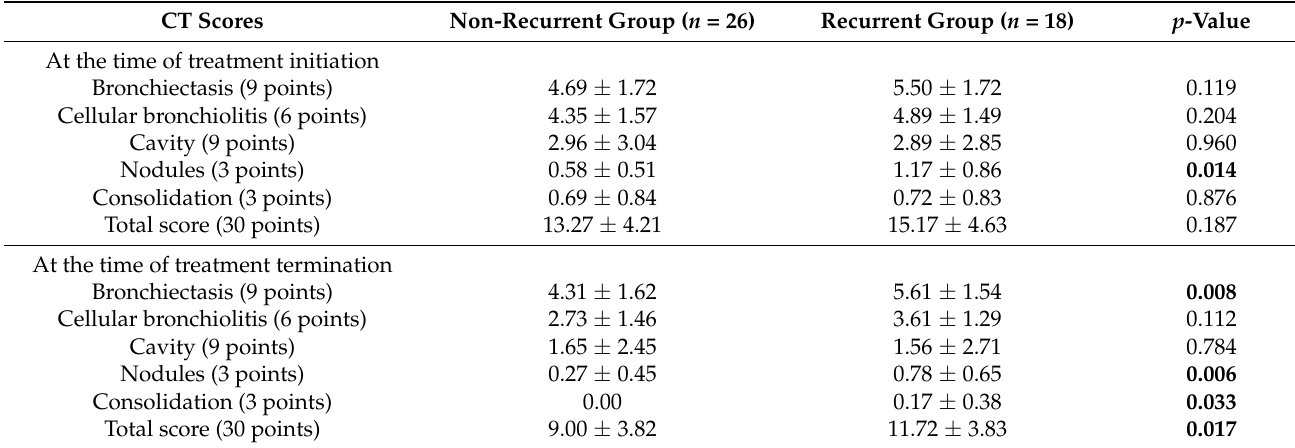
Table 2. Comparison of CT scores between patients with and without recurrent nontuberculous mycobacterial pul- monary disease.